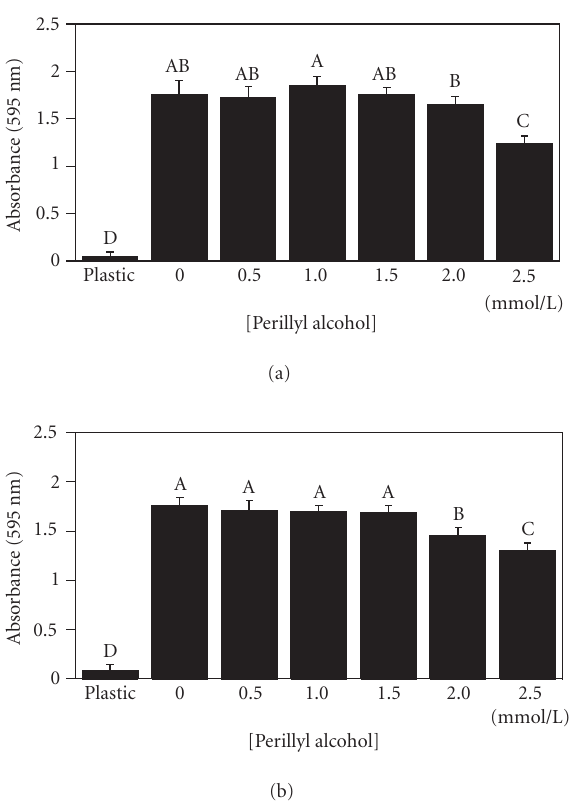
Figure 3. Perillyl alcohol ( ≤ 1 . 5mmol/L) does not interfere with breast cell adhesion to fibronectin. MCF-10A cells (a) or MDA-MB-435 cells (b) were plated on fibronectin for 30minutes in the presence of the indicated con- centrations of perillyl alcohol. Adherent cells were quantitated by staining with crystal violet, solubilizing adherent dye, and measuring absorbance at 595nm. Results expressed as mean ± standard deviation ( n = 8). A student- Numan-Keuls test identified in (a) two partly overlapping groups (letters A and B) and two independent groups (letters C and D); and in (b), four inde- pendent groups (letters A–D), P ≤ . 05. All groups are statistically di ff erent from one another (panel (a), ANOVA F:[6,55] = 144.88, P < . 0001; panel (b), ANOVA F:[6, 41] = 252.45, P < .